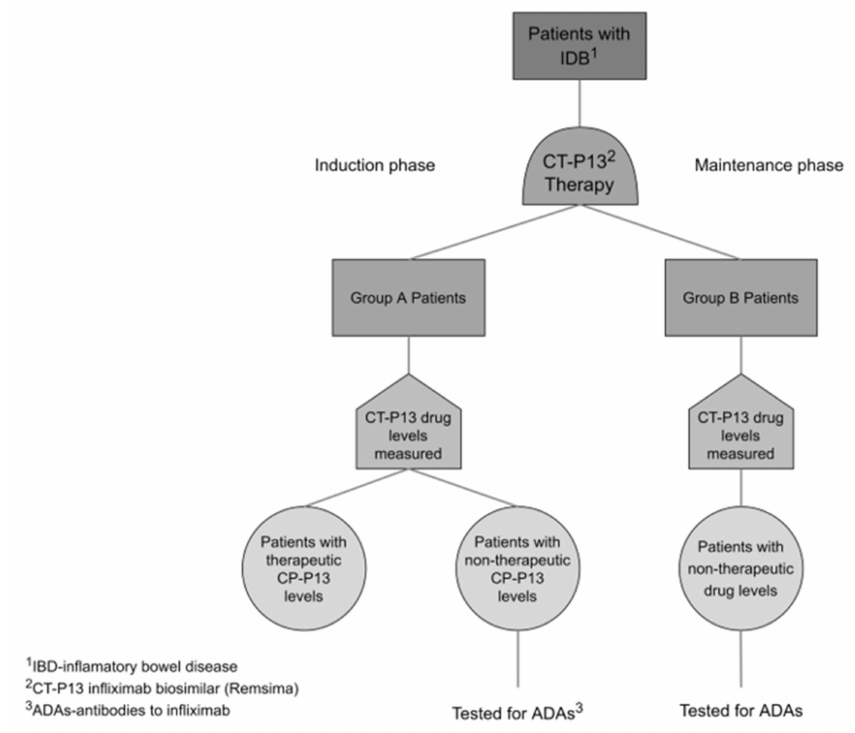
Figure 1. Study Design.